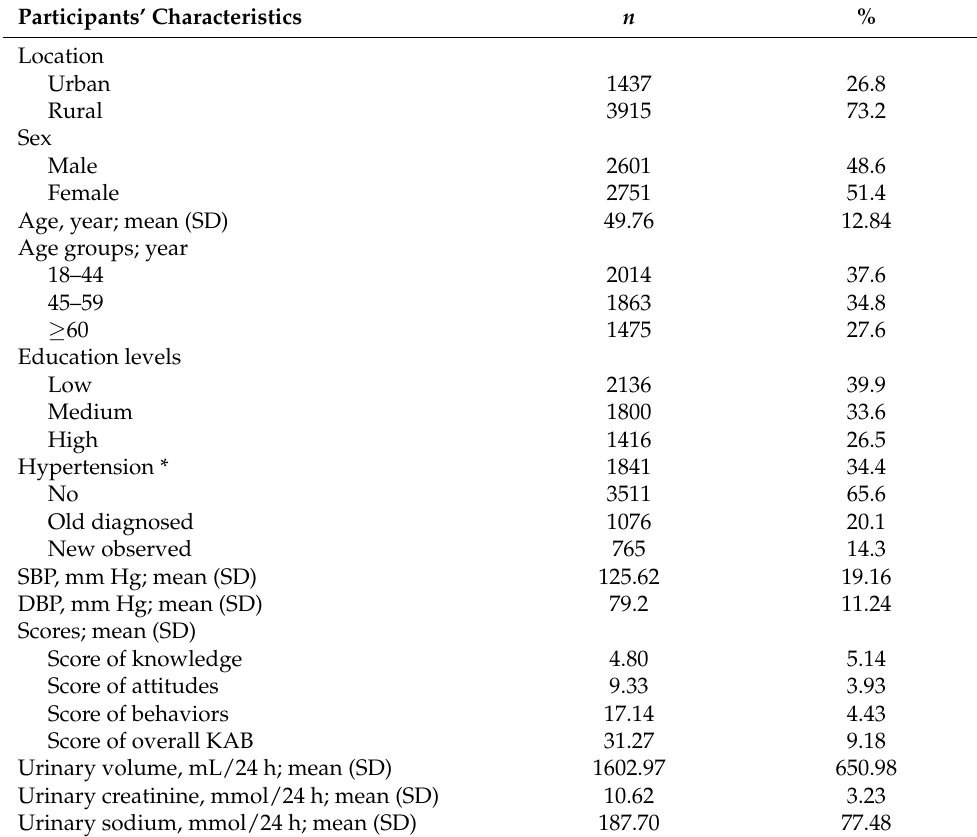
Table 1. Characteristics of participants in the study ( n =